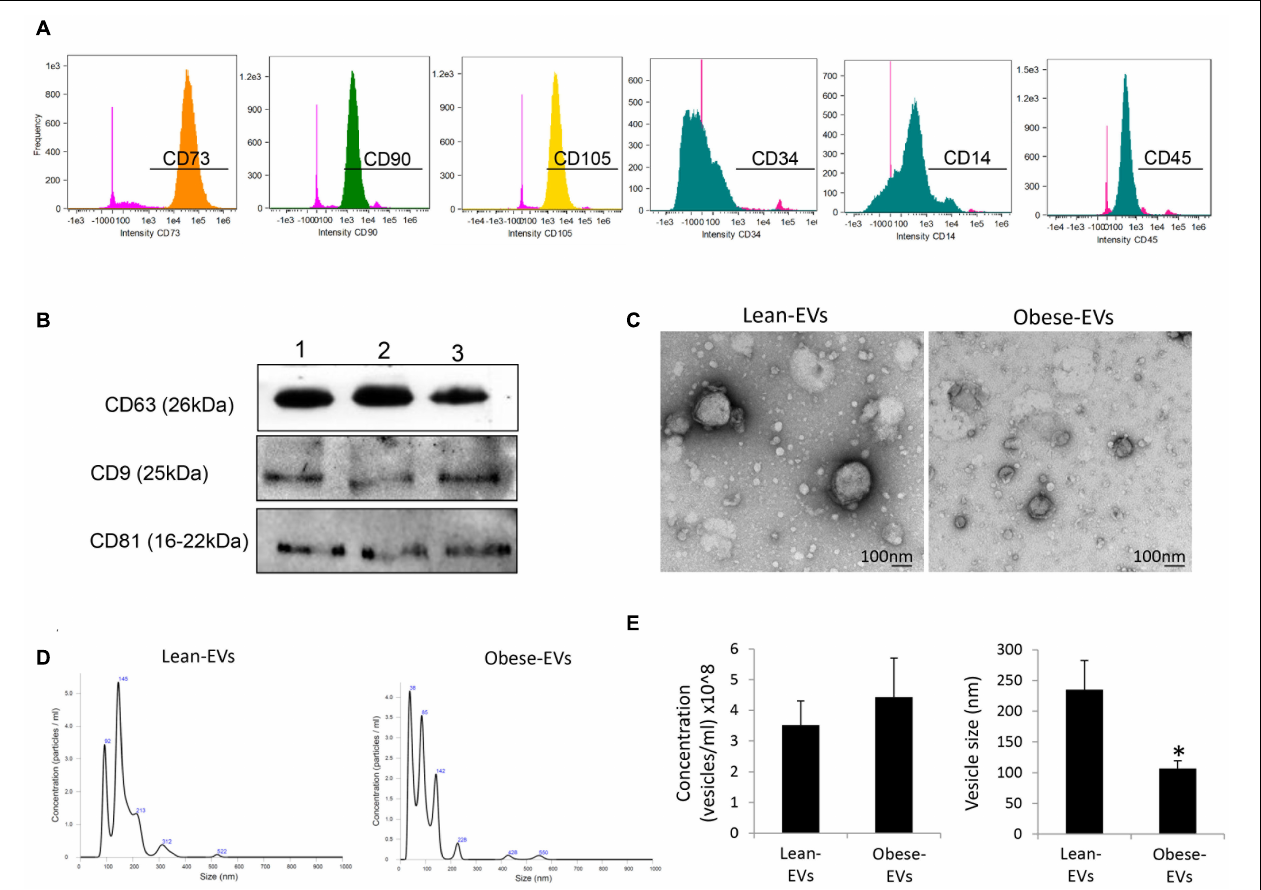
FIGURE 1 | Characterization of ASC-derived EVs and their daughter EVs. (A) Flow cytometry analysis of human ASCs. Cells were stained with anti-CD73, CD90, CD105, CD14, CD34, and CD45 antibodies. (B) ASC-derived EVs expressed common EV markers, including CD9, CD63, and CD81 by Western blotting. (C) Transmission electron microscopy showing ASC-derived lean- and obese-EVs exhibiting the classic “cup-like” morphology. (D) Representative size-distribution curve of lean- and obese-EVs by nanosight tracking analysis (NTA). (E) Quantification of EV concentration and size by NTA (Student’s t -test). * p < 0.05 vs. Lean-EVs.